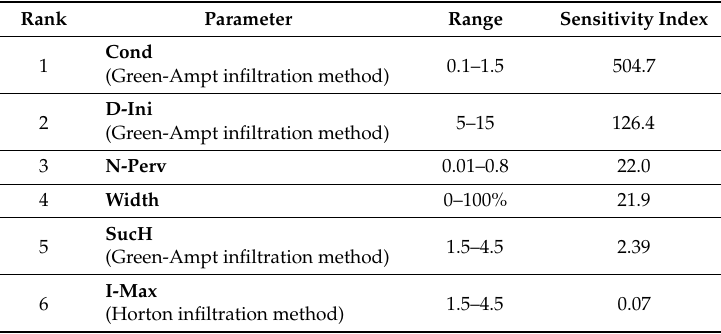
Table 7. Sensitivity index values for parameters from